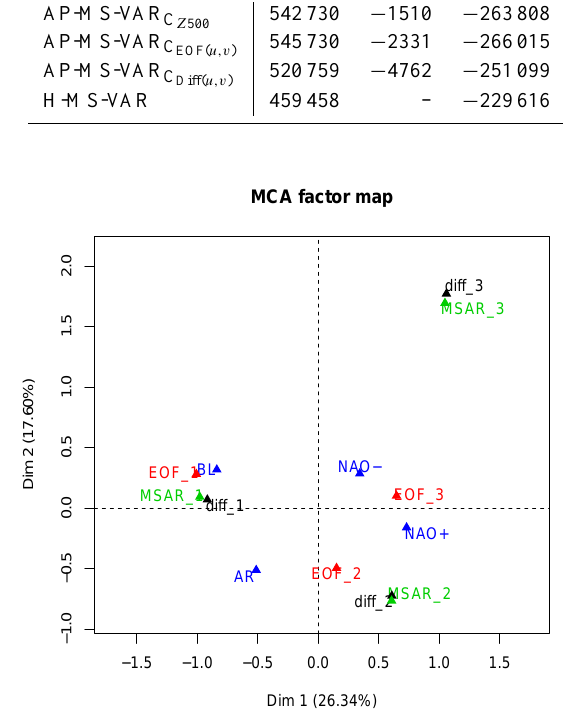
Figure 7. First plan of the multiple correspondence analysis made of the four classifications. Each regime of the four classifications is